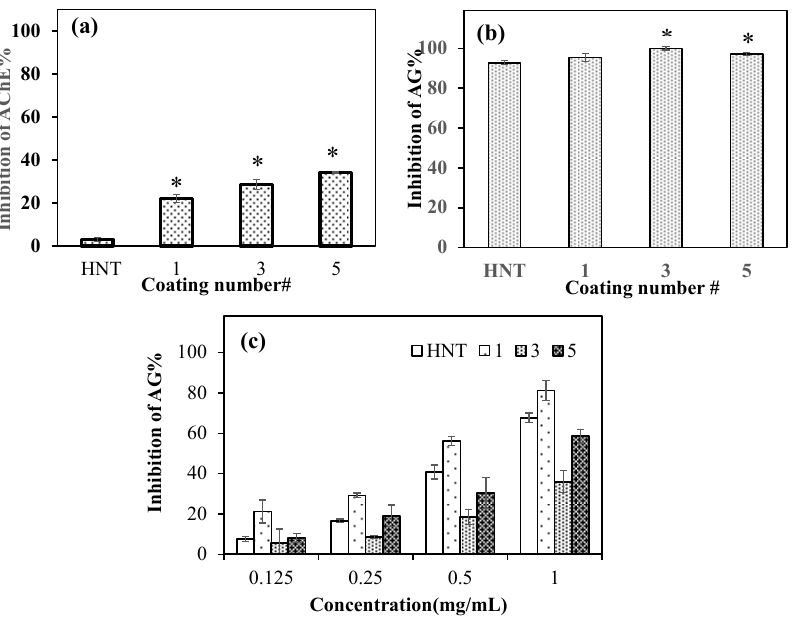
Figure 6. ( a ) AChE and ( b ) AG enzyme inhibitions by HNT, PDOPA1@HNT, PDOPA3@HNT and PDOPA5@HNT at 2.0 mg/mL concentration, a t-test was used to determine if PDOPA@HNT were significantly different from bare HNT (* p < 0.05 vs. control), and ( c ) AG enzyme inhibitions by HNT, PDOPA1@HNT, PDOPA3@HNT and PDOPA5@HNT at various concentrations (0.125, 0.25, 0.5, and